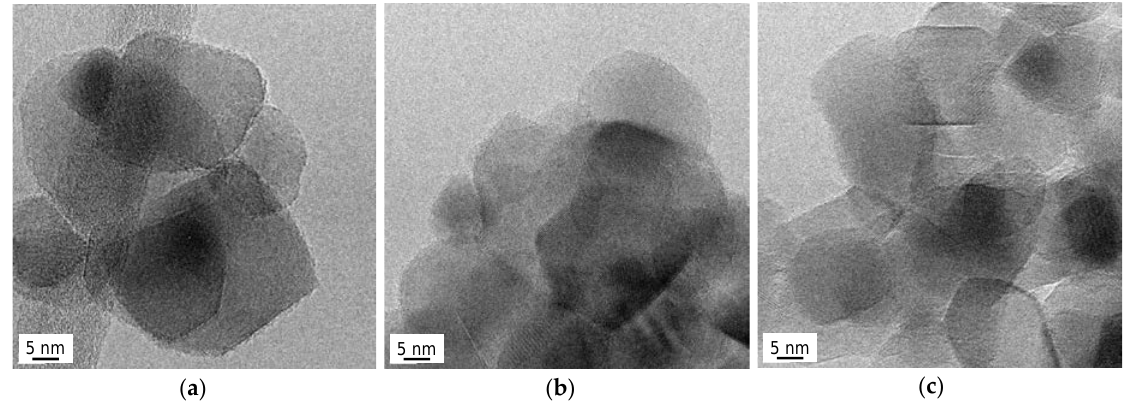
Figure 6. HRTEM images of ( a ) P25; ( b ) D1.0Cu/P25, and ( c ) I1.0Cu/P25. Instrumental magnification 300,000 × .